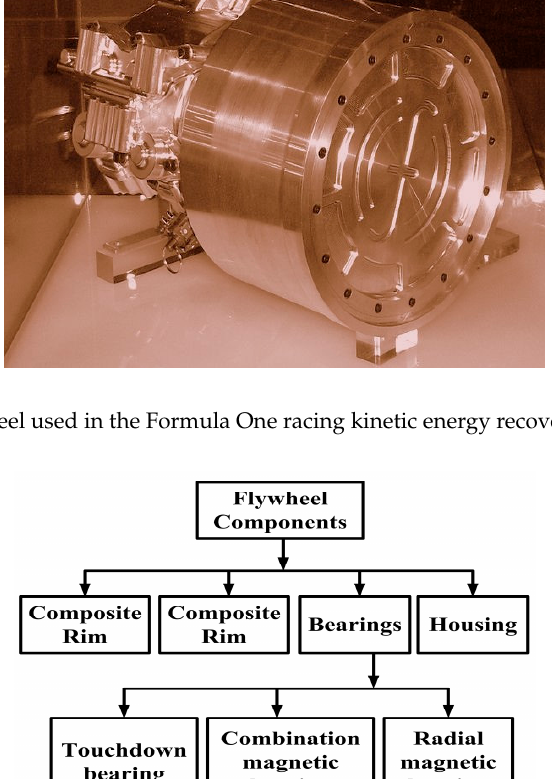
Table 13. Relative energy and power densities of different energy storage systems [63].